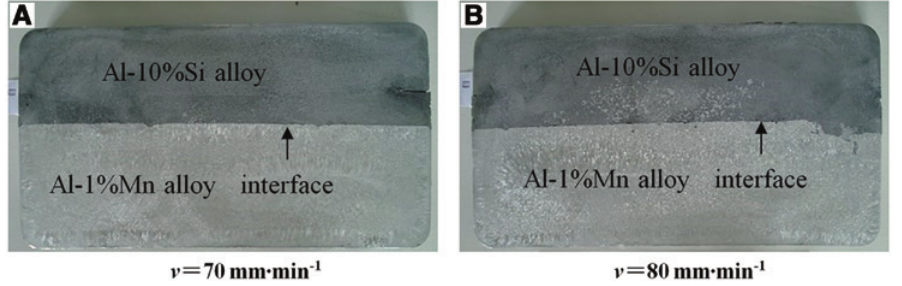
Figure 5: Macrostructures of clad slab on cross section with different casting speed: (A) 70 mm·min -1 and (B) 80 mm·min -1 .